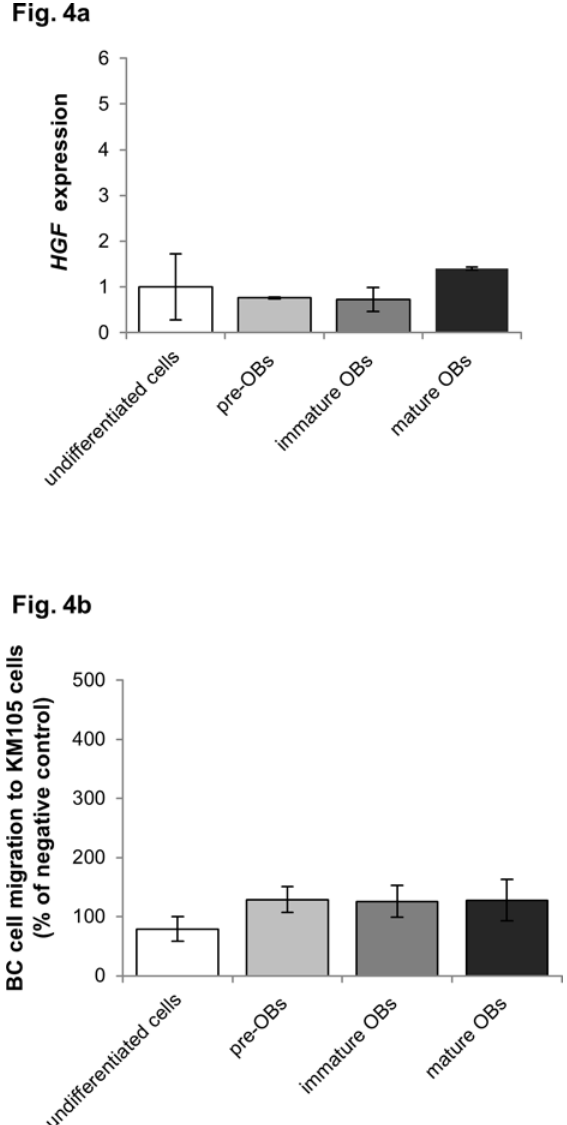
Fig 4. CM of pre-OBs derived from HGF-negative HS27 cells do not induce BC cell migration. (a) Low HGF gene levels in HS27A-derived pre-OBs . mRNA expression of HGF was analyzed by quantitative PCR and expressed as fold increase of undifferentiated cells. (b) CM of HS27A-derived pre-OBs do not induce BC cell migration . Wound healing assay was performed to assess migration of the MDA-MB231 BC cell line in the presence of CM from HS27A-derived osteolineage cells. Results are expressed as percentage of negative